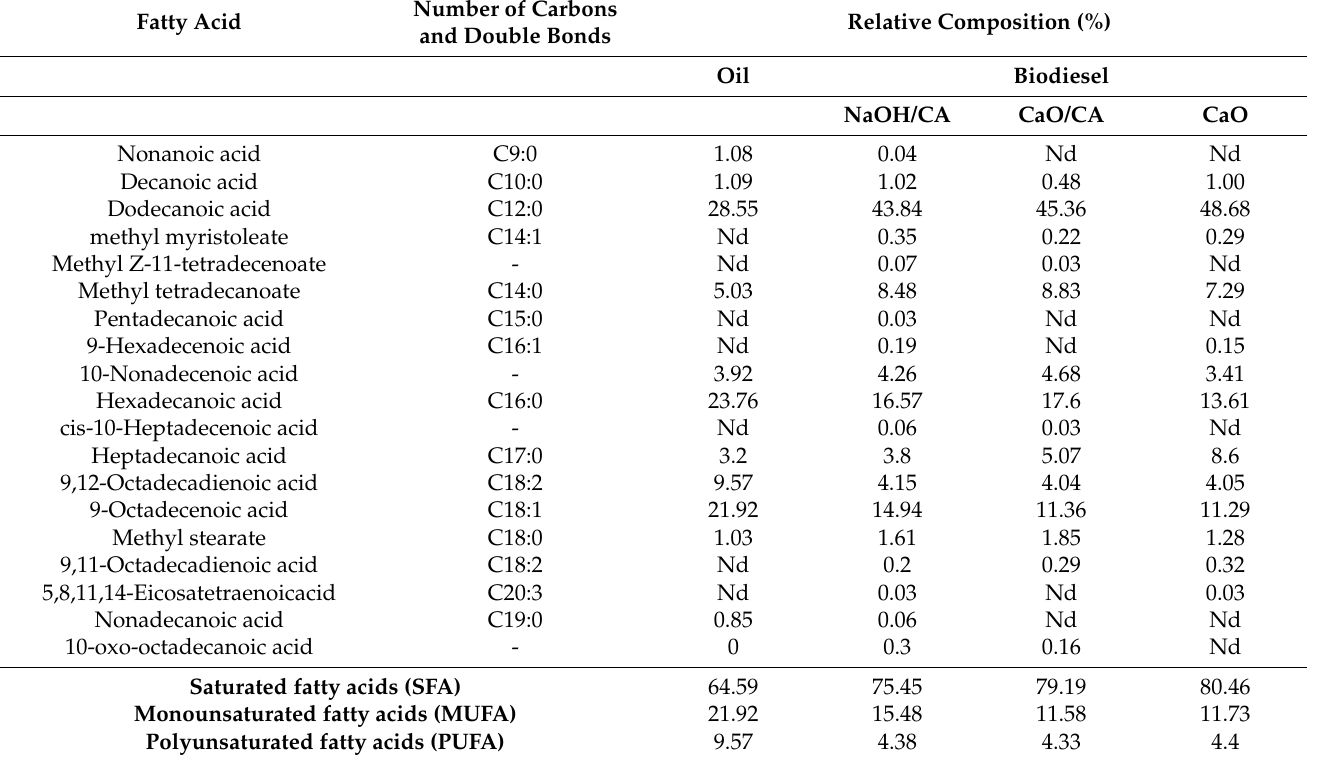
Table 4. Fatty acid composition of biodiesel synthesized from